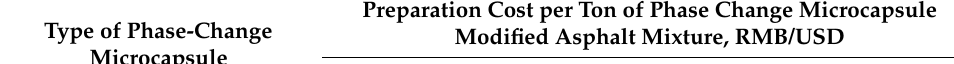
Table 18. Preparation cost of phase change microcapsule modified asphalt